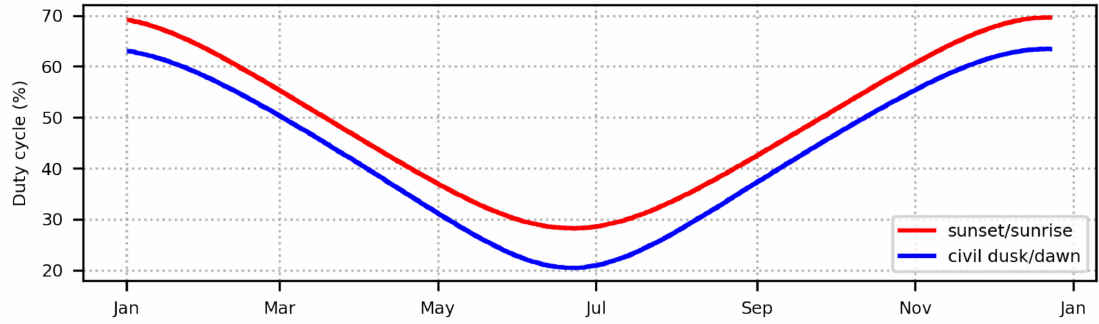
Figure 6. The duty cycle for power consumption for the city of Gdansk.